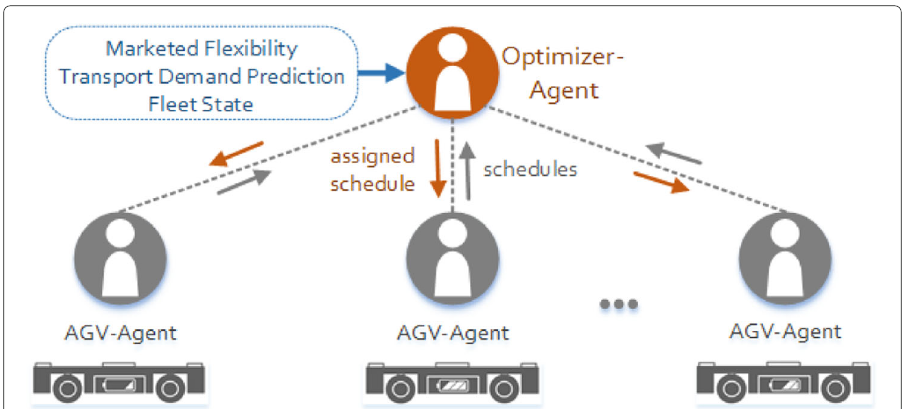
Fig. 11 Multi-agent system (MAS) for scheduling of